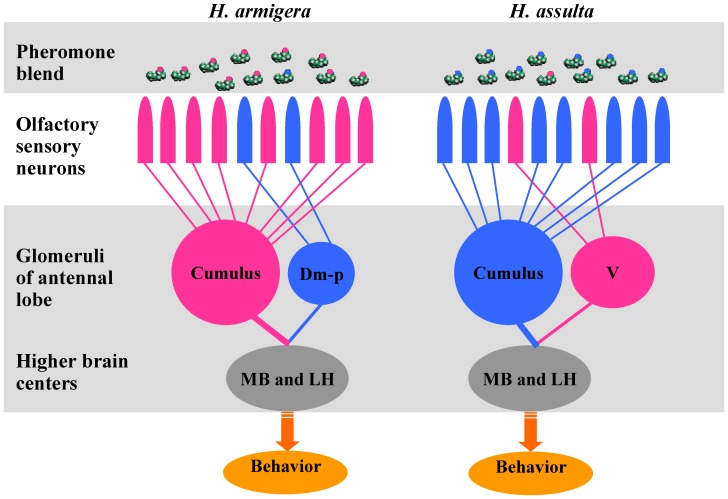
Olfactory processing to the binary pheromone mixtures with reversed ratios in two Helicoverpa species.Dm-p, posterior dorsomedial unit; V: ventral unit; MB: mushroom body; LH; lateral horn.